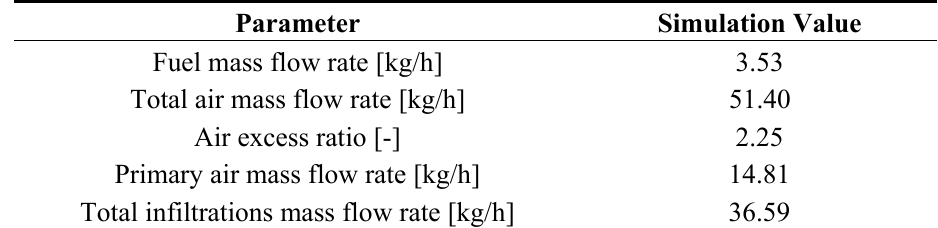
Table 2. Measured conditions of the boiler.